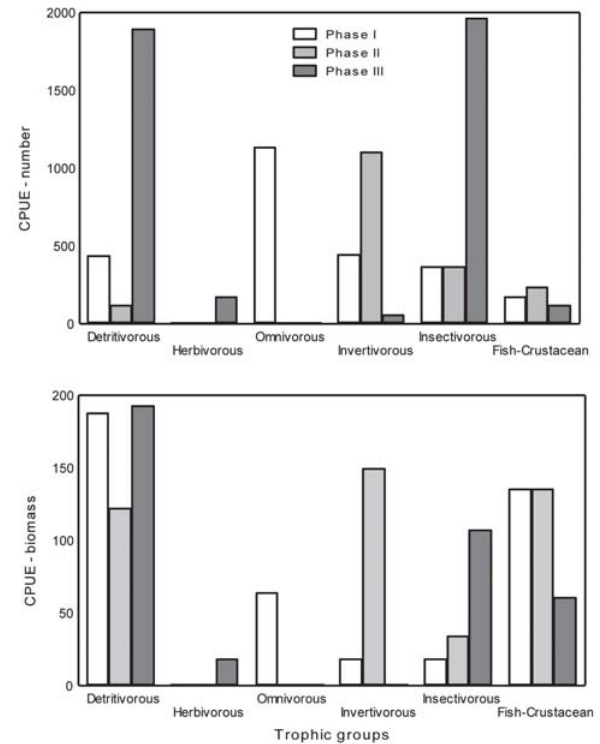
Fig. 3. Capture per unit of effort (CPUE), in abundance (a) and biomass (b) from different trophic